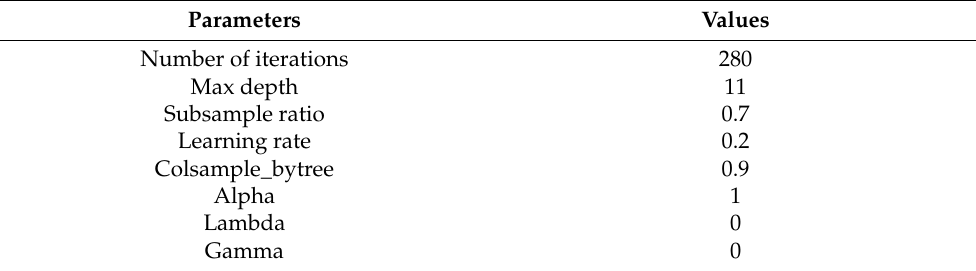
Table 3. Hyper-parameter tuning (XGBoost model with 50 m buffer radius) .